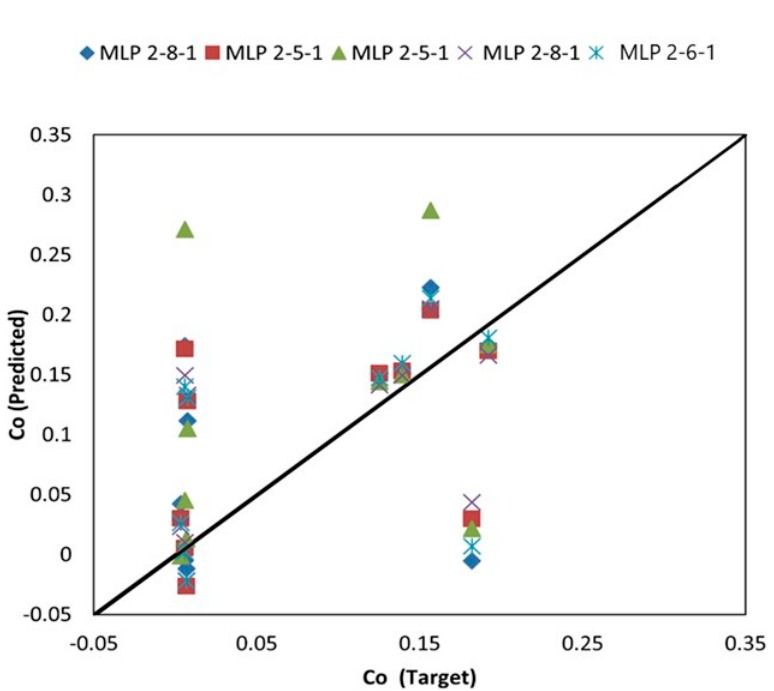
Figure 5. Scatter plot of target vs. output Co using different neural networks models dependent on MLP in validation stage. Table 2. Correlation coefficients and RMSE for different MLP topologies in all stages for Co .